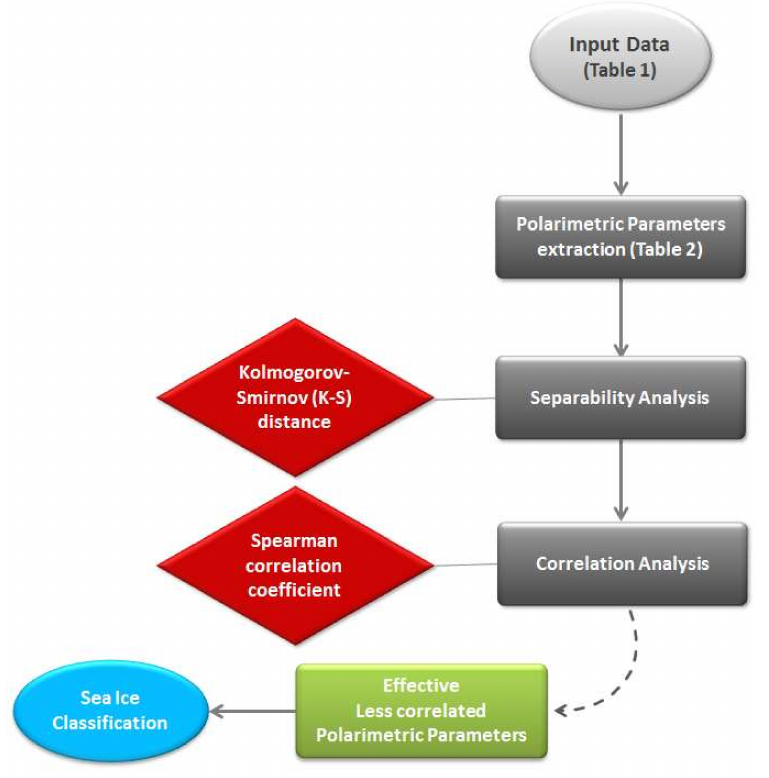
Figure 2. Methodology flowchart of the